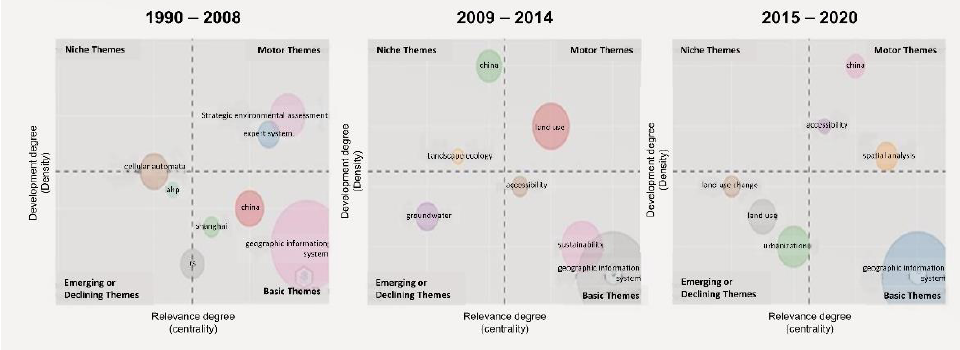
Figure 3. Thematic maps of keywords 1990 – 2020.